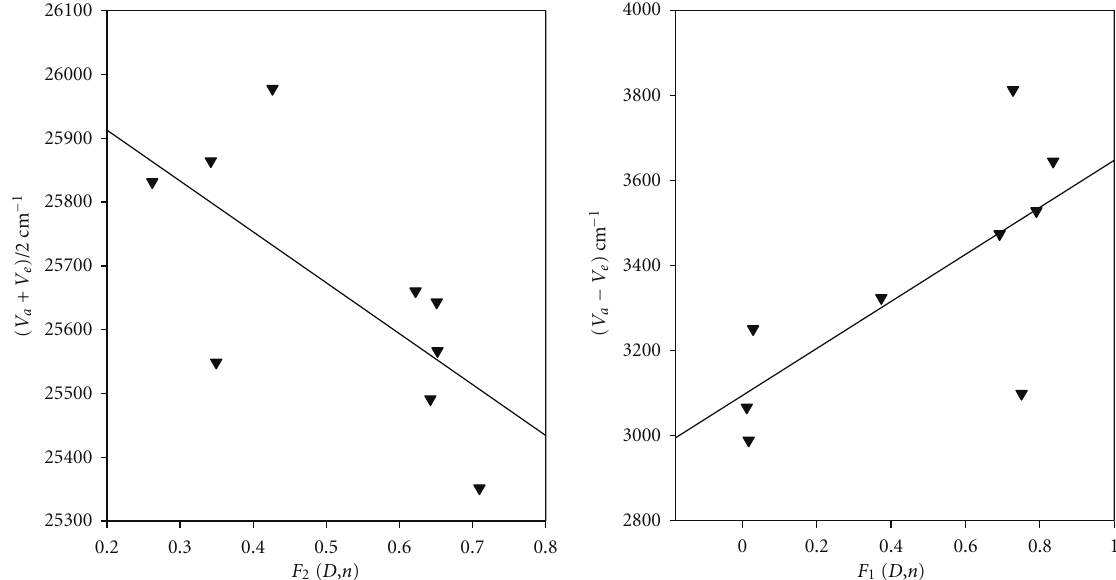
Figure 4: Stokes shift versus the functions F 1 ( D , n ) and F 2 ( D , n ) for POPOP in di ff erent solvents.